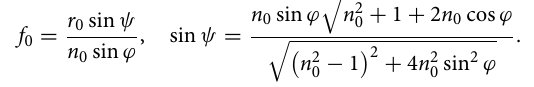
where θ L is the radiation angle in the LC layer (see Supplementary information S2). The waveforms applied to the B k electrodes adjust the focusing position F 1 to convert the radiated light to five parallel beams (see Supple- mentary information S6). Rotation of this waveform produces a horizontal scan around the axis L. Beam‑collimating and rotating principle in the horizontal direction. Figure 2a shows a portion of an electrode pair composed of the ITO and Al electrode, in which vertexes of zigzag shapes between the two electrodes of B k overlap together and diamond shape electrodes such as b 2k and b 2k+1 are aligned in the radial direction, where b 2k are generated from the combination of Al electrodes B k and ITO electrodes B k , and b 2k+1 are from Al electrodes B k and ITO electrodes B k+1 . The voltage amplitude at the electrodes b 2k+1 becomes the average between those at the electrodes b 2k and the electrodes b 2k+2 . When the AC signals are applied to the electrodes of B k , the ERIs of such as N 2k or N 2k+1 , in response to the voltages v 2k or v 2k+1 at electrodes b 2k or b 2k+1 , are aligned in the radial direction. Figure 2b show examples of voltage waveforms applied to the B k electrodes. For a non-rotating condition (or a static state), the AC waveform envelopes are constant, with their signal amplitudes varying sinusoidally according to the value of k. Amplitude distribution between the electrodes allows the beams to be collimated. Under rotating conditions, the envelopes have a sinusoidal shape and the phase between the neighbor signals shifts together by 1/60f H . Collimated beams can be rotated by applying a phase shift to the sinusoidal amplitude. Figure 2c shows relationships under a static condition between a voltage waveform V B applied to the B k elec- trodes and the response of the ERI to an azimuth angle φ (= 2kπ/60 or (2 k + 1) π/60). The waveform V B has a periodic number m (m = 5 or 10) per revolution and is represented by a collection of elements of v 2k or v 2k+1 . N 2k (or N 2k+1 ) is given from v 2k (or v 2k+1 ) and its curve traces a shape that is the inverse of waveform V B . If N 2k > N 2k+1 as shown in Fig. 2c, the guided light (shown by the red arrow in Fig. 2a) deflects to the higher index side (in the direction of the blue circling arrows) at the intersection with the boundary of the diamond-shaped electrodes. The differences in indexes are small. However, since the guided light passes through more than 30 boundaries within the range of area B, the accumulated deflection angle of the red arrow eventually totals about 10 degrees in comparison with the blue and straight arrow. This deflecting principle is similar to that of an electro-optic scanner 20 . The rotating condition corresponds to the movement of the waveform at a frequency f H as indicated by an arrow shown in Fig. 2c (see information S7). Figure 2d shows a combination of a perspective illustration of light radiated from the coupler C and a cross- sectional drawing of light refracted at the rod lens surface. Figure 2e shows a ray-tracing result for light that propagates in the guided layer, is then radiated from the coupler C, and penetrates RLE. If no difference in volt- age is applied to the B k electrodes, the guided light propagates in the direction of the blue arrow in Fig. 2a: the radiated light is focused at point F 0 on the center axis L of the rod lens and travels in a straight line in the radial direction as shown by the blue arrows in Fig. 2d. In this case, the radiated light becomes a widely spread beam with a conical wavefront. When applied to the B k electrodes, the guided light propagates in the direction of the red arrow in Fig. 2a and the radiated light is focused on point F 1 , which moves the distance of f 0 from F 0 . The light becomes a parallel beam after refraction at the side surface of the rod lens, as shown by the red dotted arrows. This beam is generated by the period number m of the waveform, that is, five or ten. To correct the aberration of the radiated beams (see Supplementary information S8), the light focused on F 1 needs a phase difference of n 0 f 0 ( 1 − cos ϕ) , where